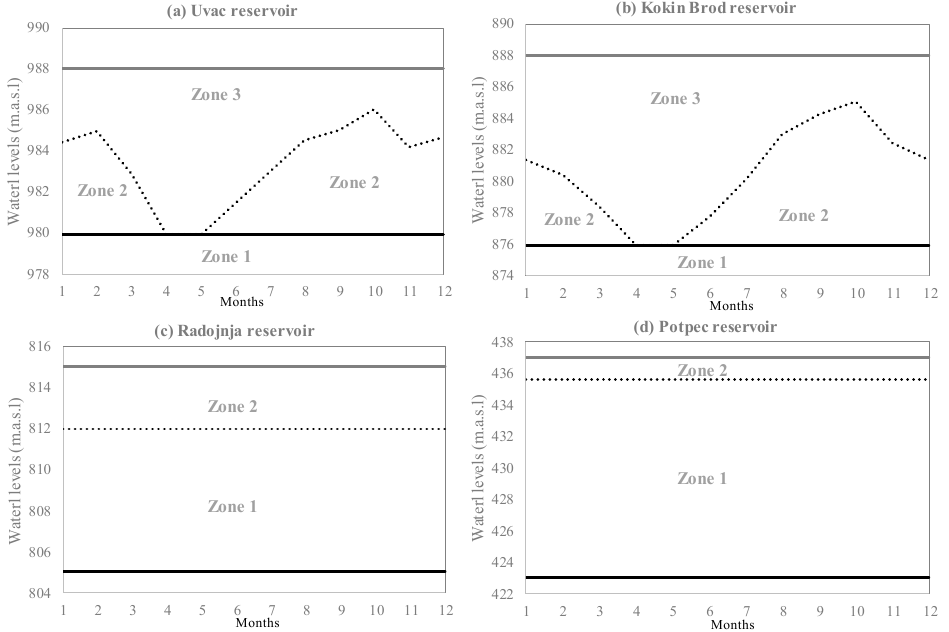
Figure 3. Reservoir release rules for the Lim water system: ( a ) Uvac reservoir, ( b ) Kokin Brod reservoir, ( c ) Radojnja reservoir, ( d ) Potpec reservoir.